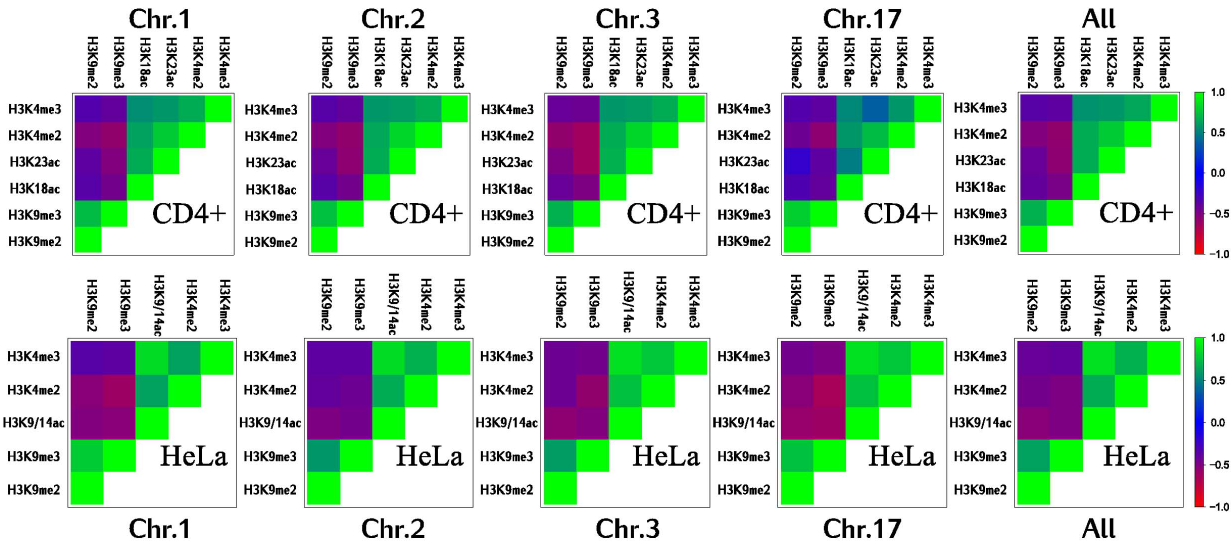
Figure 2. Euchromatin and heterochromatin marks become anti-correlated on a coarse scale. Pearson’s correlation between modifications within bins of 100 kbp for different chromosomes and two cell lines. Instead of taking into account the individual scores in a bin, we simplify the content by the sum of all scores. It can be clearly observed that euchromatic (H3K9/14ac, H3K18ac, H3K23ac, H3K4me2 and H3K4me3) and heterochromatic histone marks (H3K9me2, and H3K9me3) oppose each other for all considered chromosomes as well as for two different cell lines. We therefore show that these modifications form long domains that are still detectable on a scale of about 1000 histones.